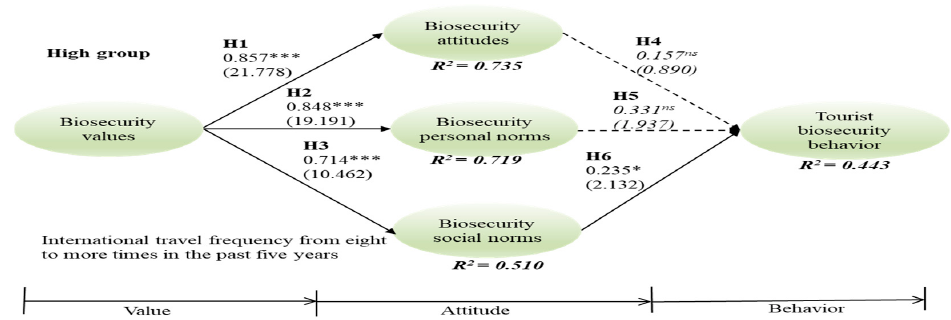
Figure 1. High group of international travel frequency. *** p < 0.001; * p < 0.5; n s = non-significant. Int. J. Environ. Res. Public Health 2021 , 18 , 4111